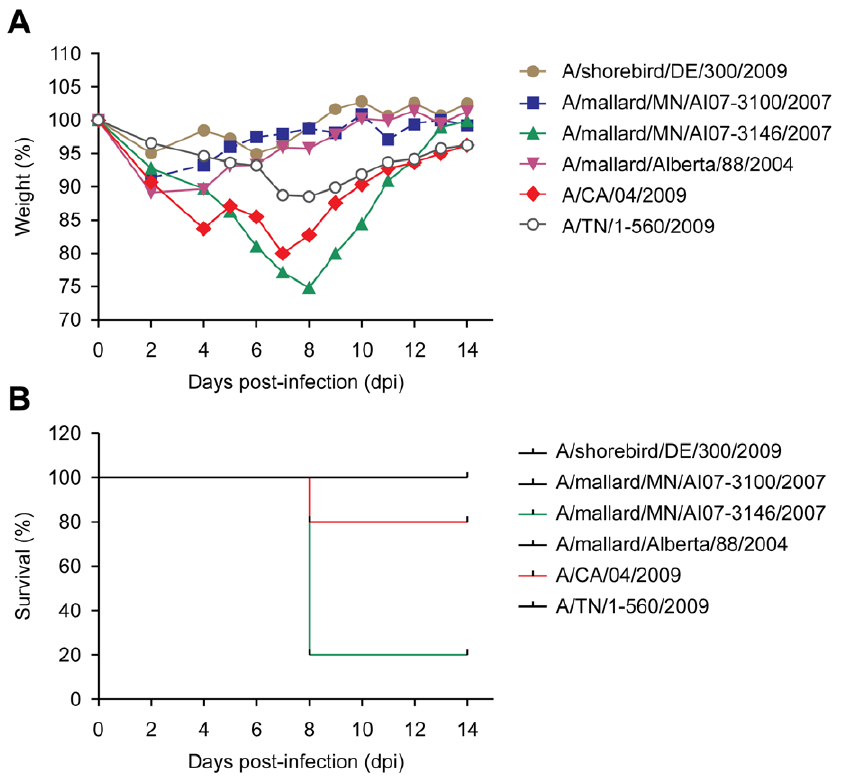
Figure 2. Percent weight loss and survival in BALB/cJ mice infected with 10 6 EID 50 of selected H1N1 isolates. (A) Daily weight loss was calculated as the percentage of weight relative to that at 0 dpi, and mean weight loss for each group is shown. (B) Mortality was recorded based on